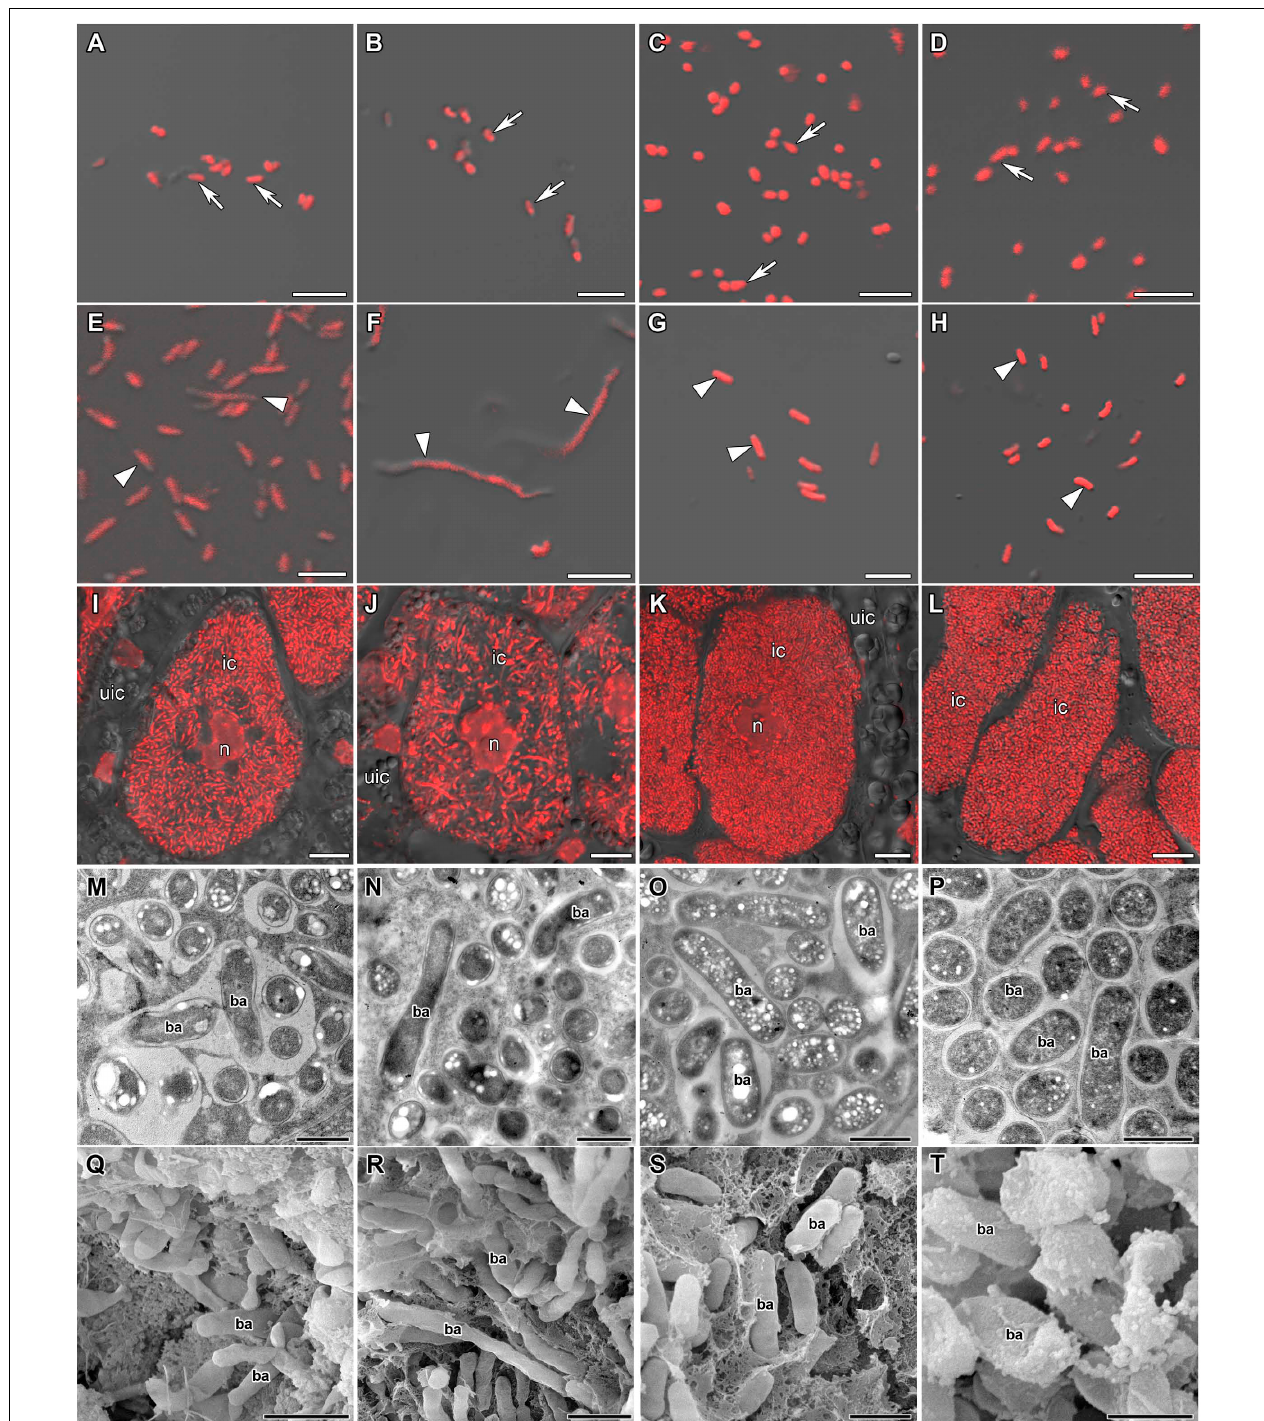
FIGURE 1 | Morphology of bacteria, bacteroids, and infected cells in G. max (A,E,I,M,Q) , G. soja (B,F,J,N,R) , P. vulgaris (C,G,K,O,S) , and L. japonicus (D,H,L,P,T) nodules. ic, infected cell; uic, uninfected cell; n, nucleus; ba, bacteroid; arrows indicate bacteria, triangles indicate bacteroids. (A–D) Bacteria. (E–H) Bacteroids. (I–L) Symbiosome arrangement in infected cells of the nitrogen fixation zone. (M–P) Ultrastructure of an infected cell. (Q–T) Scanning electron microscopy of infected cells. (A–L) Merged images of differential interference contrast and red channel (DNA staining with propidium iodide (nuclei and bacteria)). Scale bar (A–H) = 5 µ m, (I–L) = 10 µ m, (M–P) = 1 µ m, (Q–T) = 2 µ m.